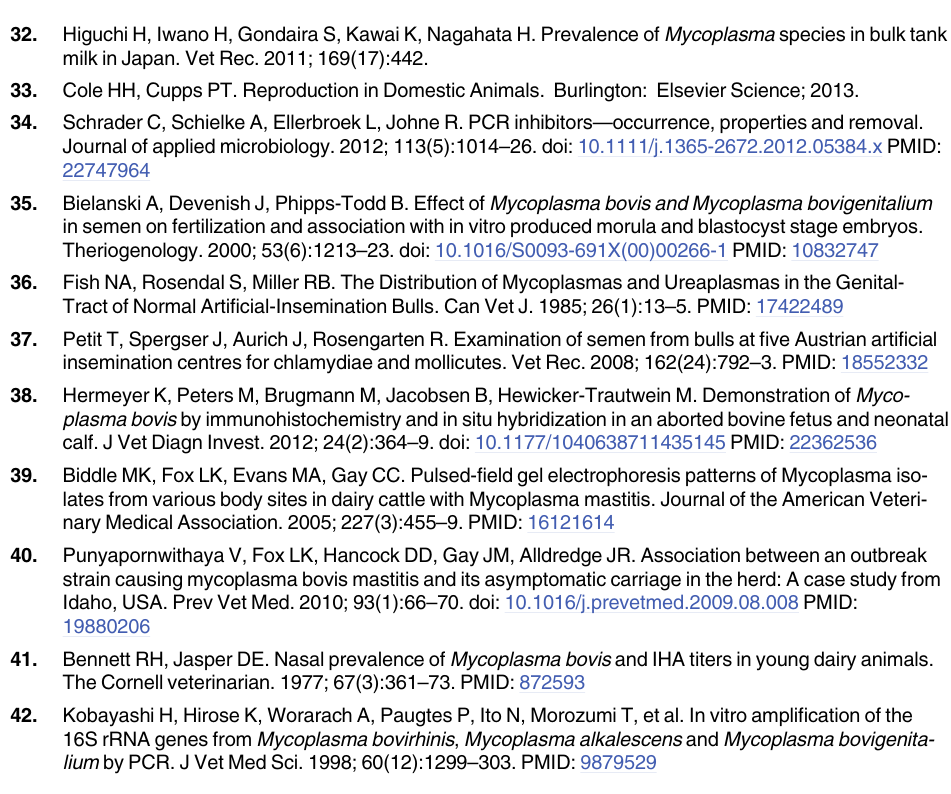
PLOS ONE | DOI:10.1371/journal.pone.0173422 March 6,